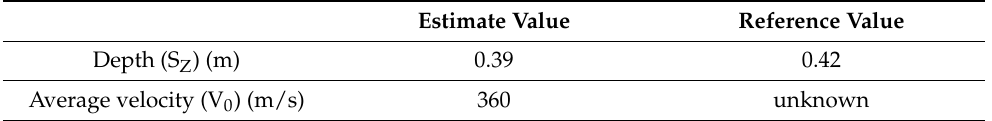
Table 3. Second example of estimation obtained with the MUSIC algorithm adapted to the problem and to Model M1 (5 sensors spaced 0.2 m apart).